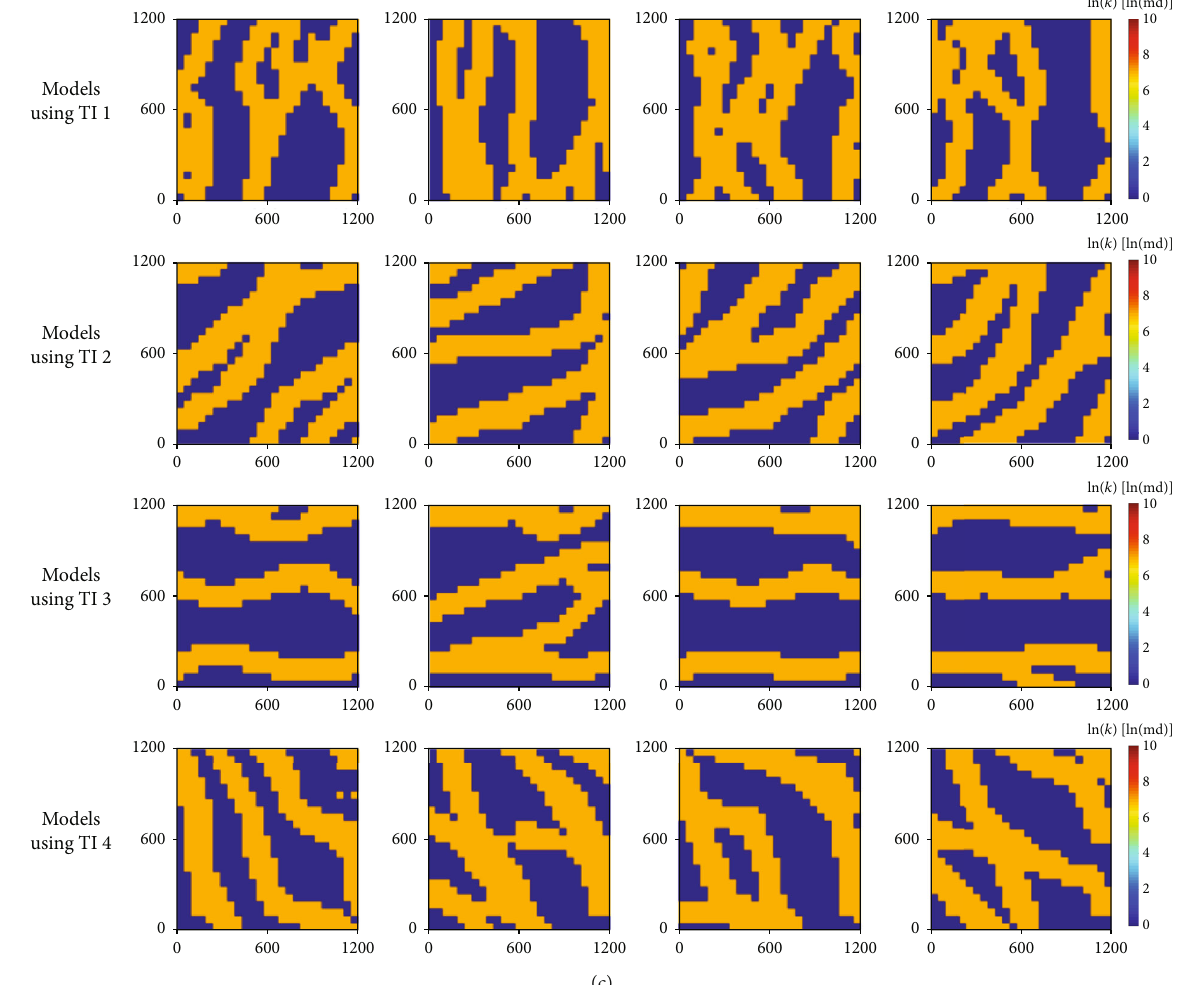
Figure 5: Generation of reference and initial models. (a) The location of injection and production wells, (b) the reference fi eld, and (c) examples of channel reservoir models based on di ff erent